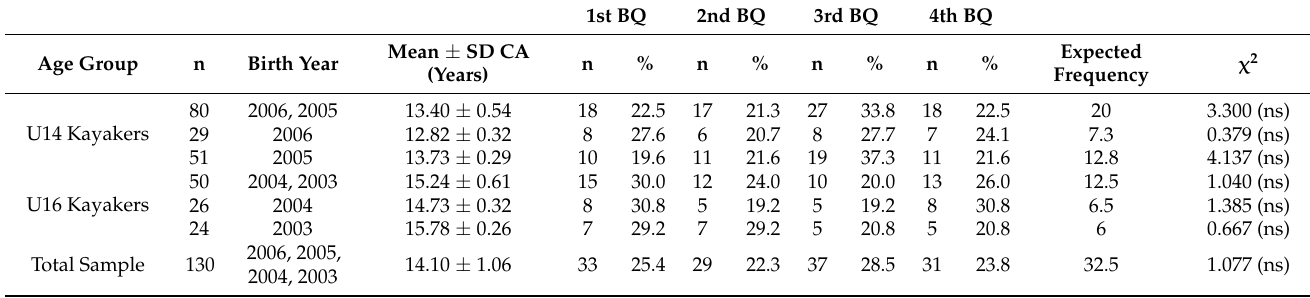
Table 1. Frequency of month and year of birth by quarter for U14, 16 and the total sample of kayakers. 1st BQ 2nd BQ 3rd BQ 4th